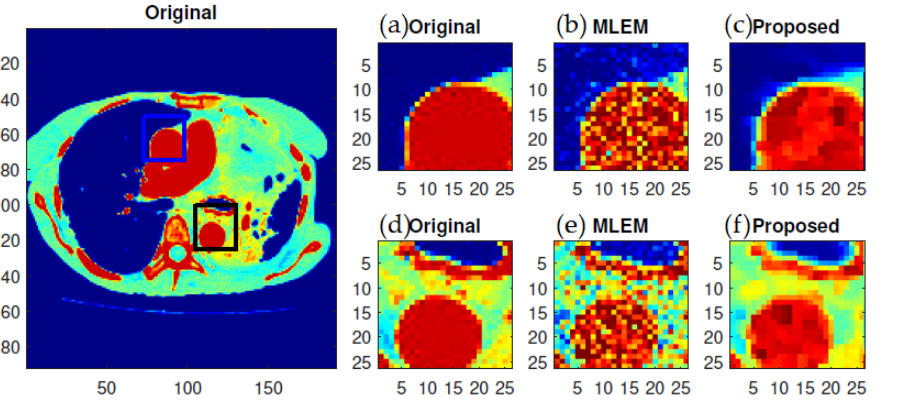
Figure 7. ROIs of standard medical image of abdomen reconstructed using various algorithms as shown under magnification: ( a , d ) the ground truth; ( b , e ) MLEM; and ( c , f ) f